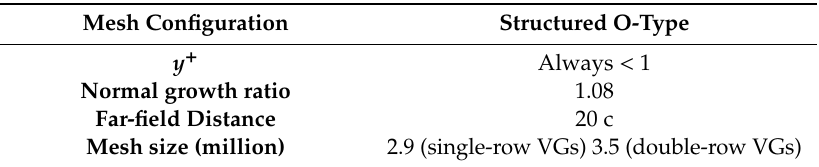
Table 1. Main features of the computational mesh.